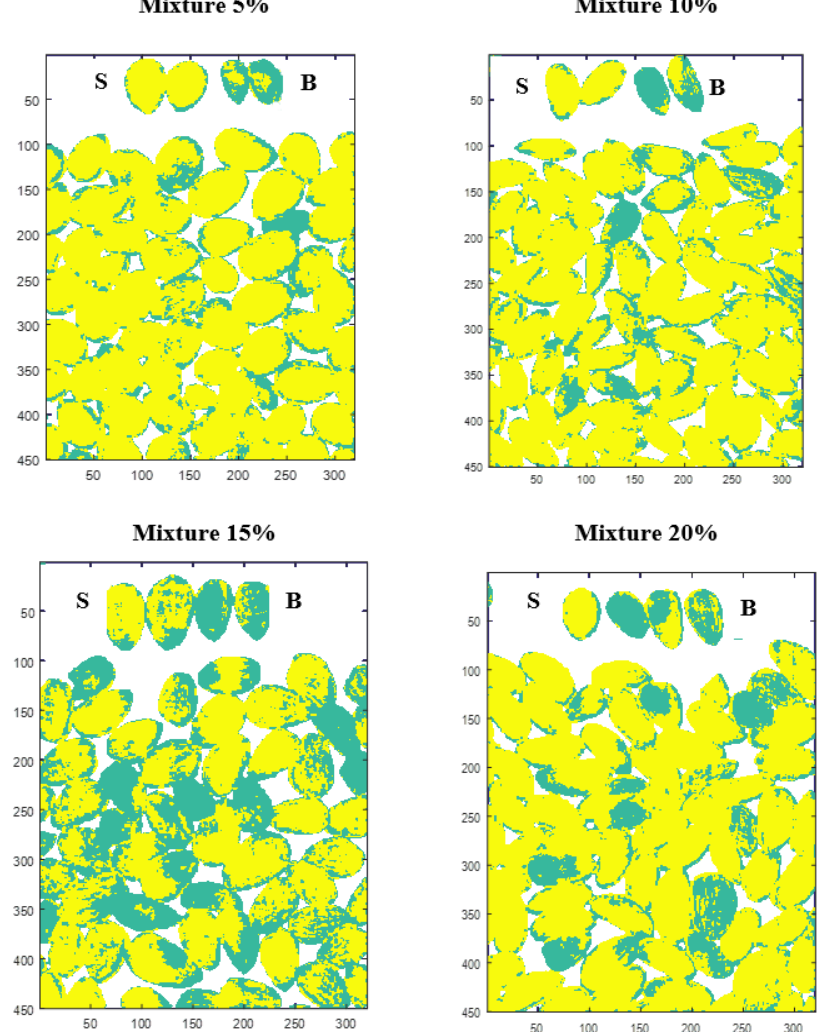
Figure 3. Pixel-by-pixel validation for the identification of bitter almonds in the mixtures.